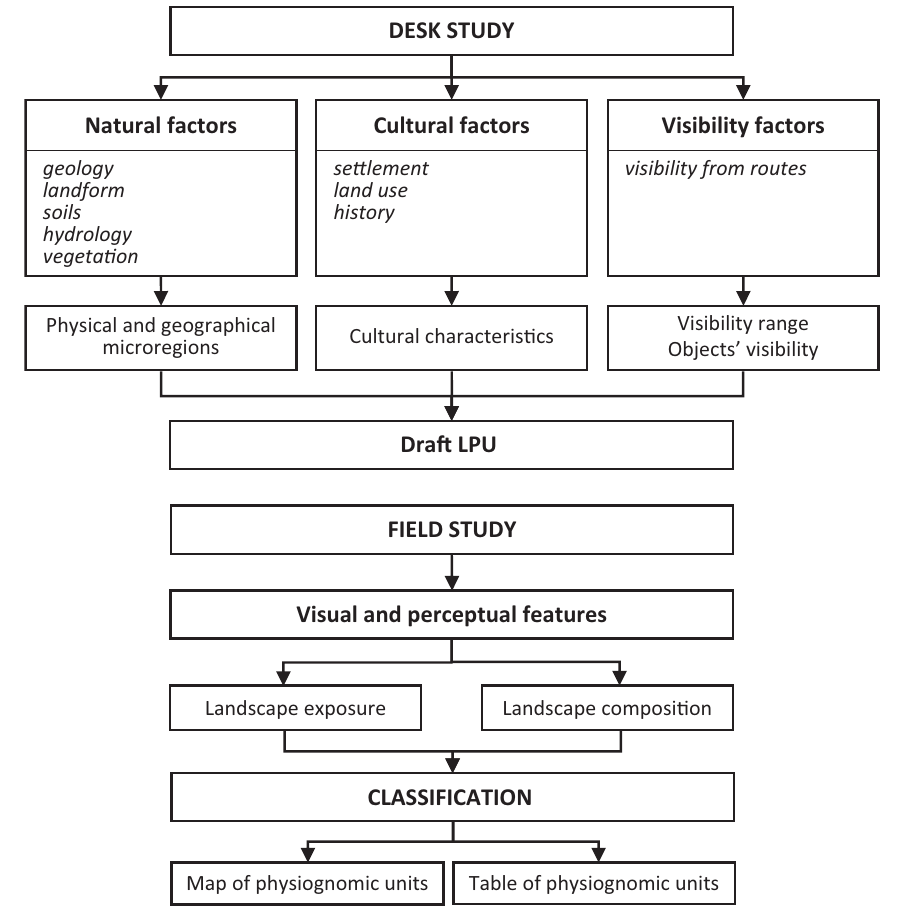
Figure 1. Methodology of identification of